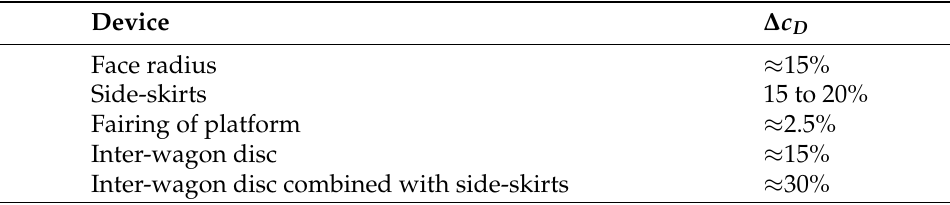
Table 1. Maximal obtained drag reduction for